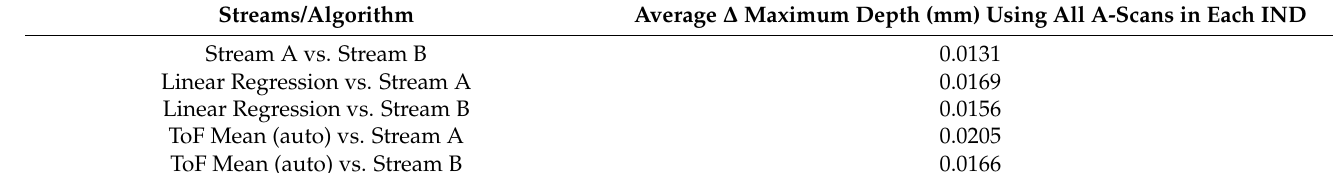
Table 2. Auto depth measurement relative accuracy based on the A-scans with the maximum depth in each IND.